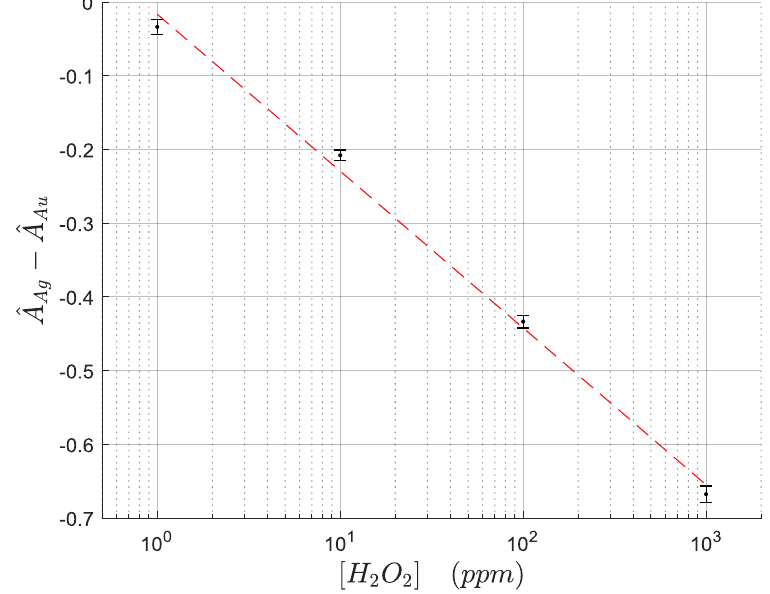
Figure 11. Calibration curve of the optical fiber sensors. The experimental measurements fit well with a linear relationship in a semilog plot, suggesting a logarithmic relationship of the measurement with the H 2 O 2 concentration.